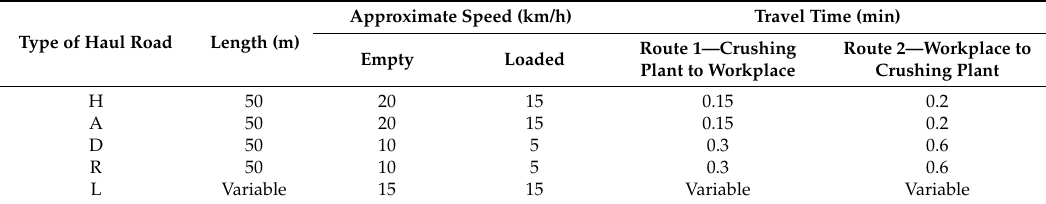
Table 1. Approximate speed and travel time of a 15-ton dump truck according to the type of haul road in the study area [34], where H denotes the haul road outside the underground mine, A denotes the adit, D denotes the decline, R denotes the ramp, and L denotes the level.